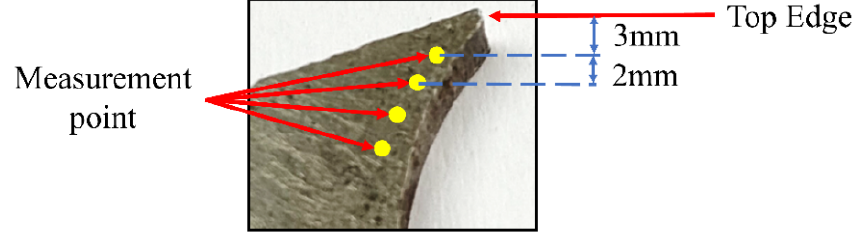
Figure 7. Measurement points of hardness on the worn cutting edge .